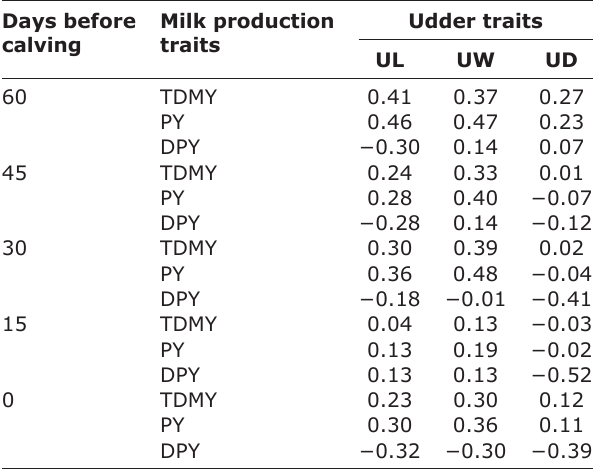
Table-2: Correlation coefficient between udder traits and milk production traits at different days of pregnancy in primiparous Nili-Ravi